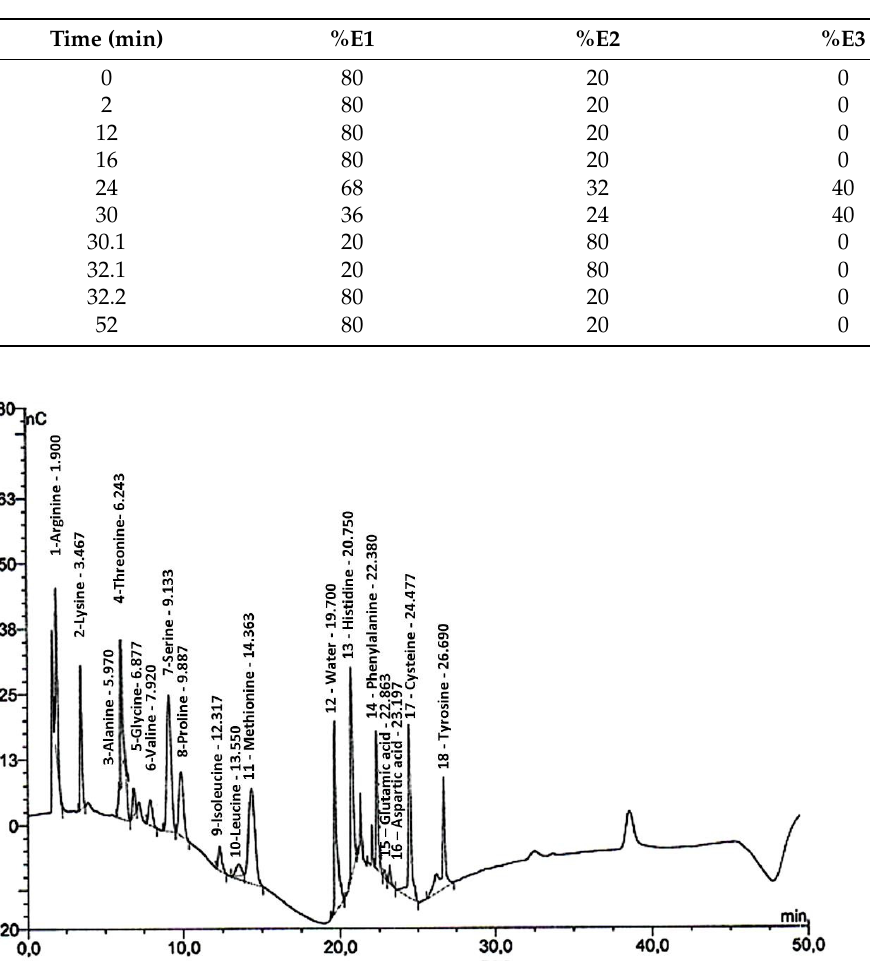
Figure 1. The chromatogram of standard of AA.